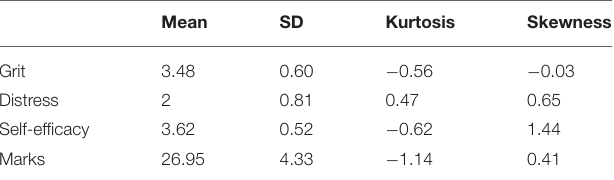
TABLE 1 | Descriptive